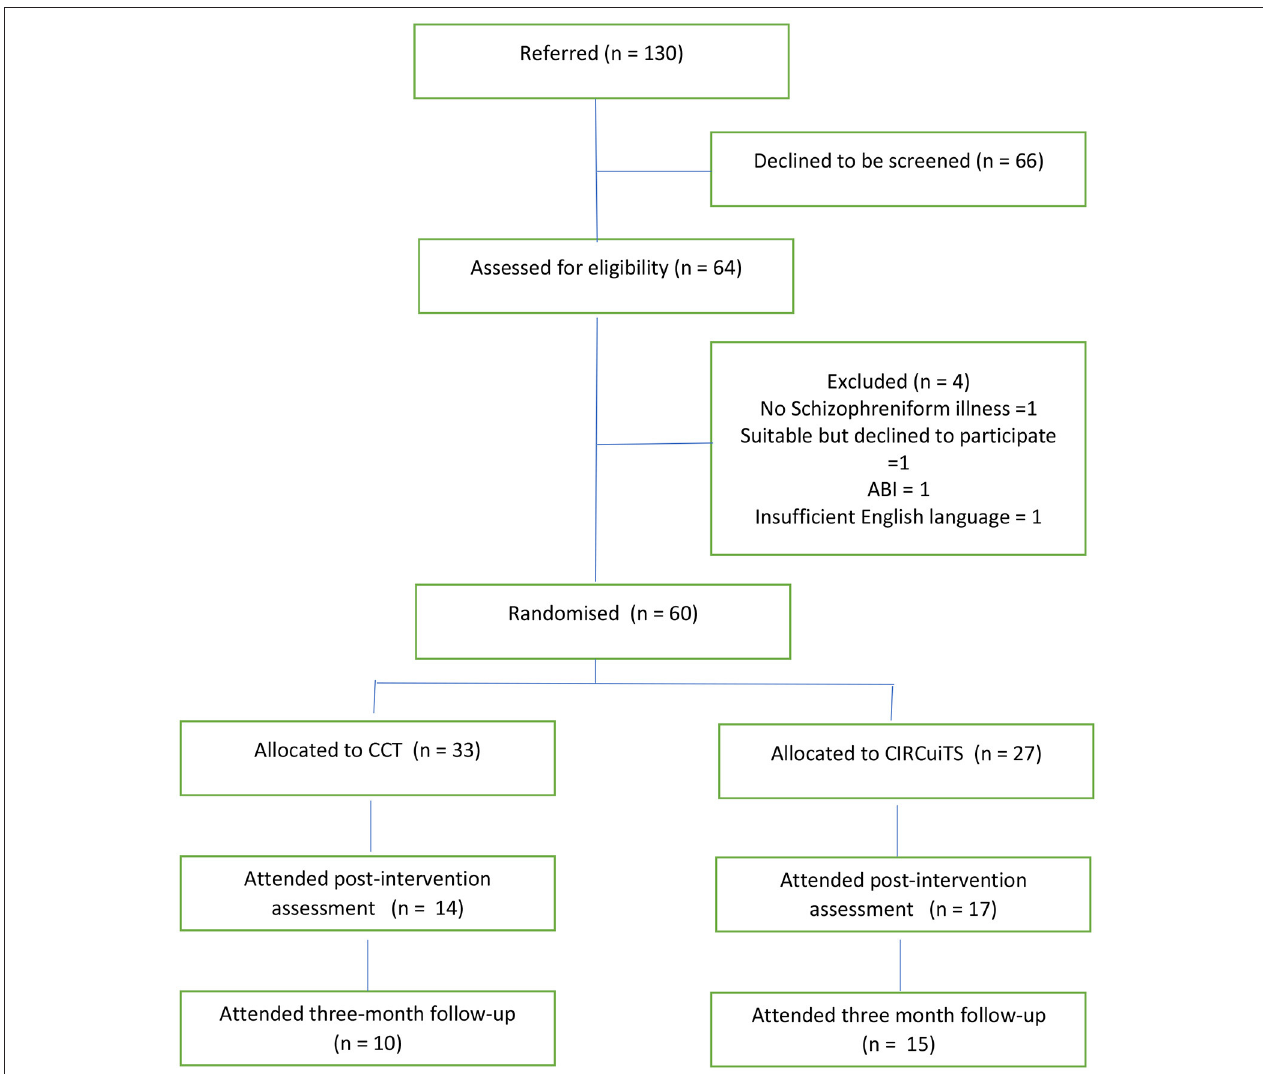
FIGURE 1 | CONSORT flow